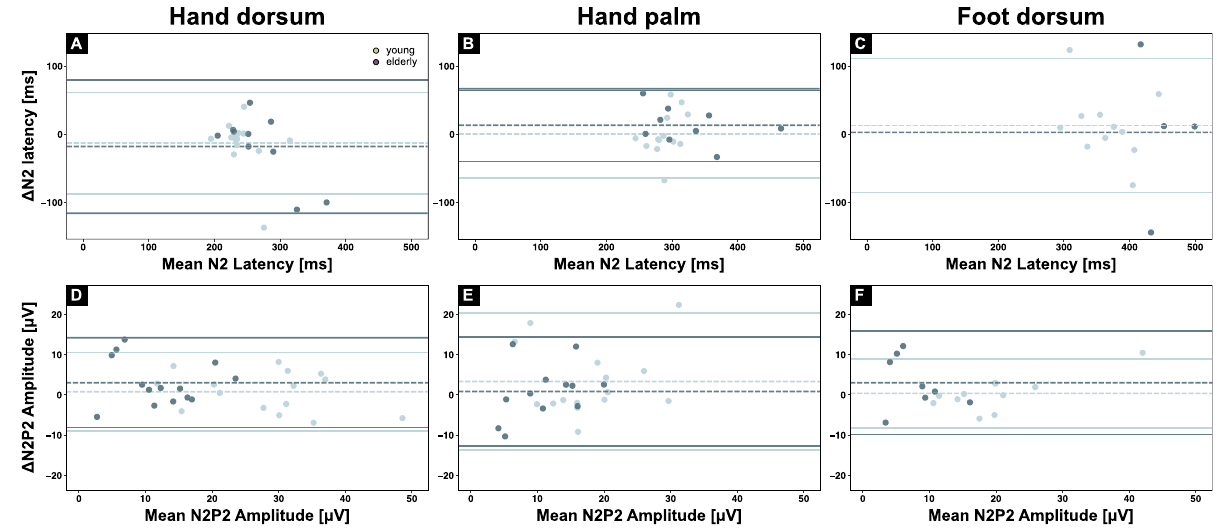
Figure 4. Reliability of cold evoked potentials. Bland–Altman plots for N2 latencies (A–C) and N2P2 amplitude (D–E) for all stimulation sites (i.e., hand dorsum, hand palm, and foot dorsum). Test–retest mean differences (dashed lines) and limits of agreements (solid lines) are shown for the young (light blue) and elderly age